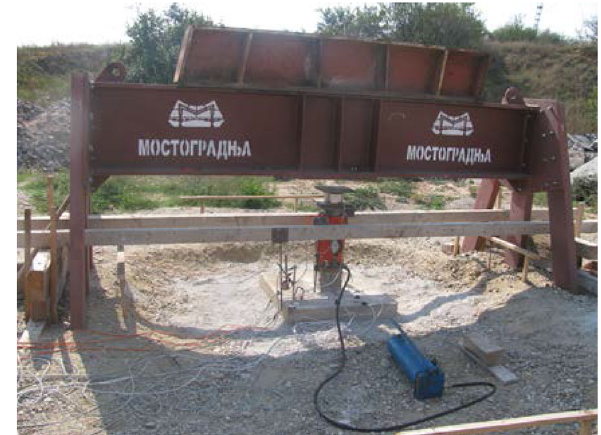
Fig. 4 Granulometric composition of the subgrade soil.